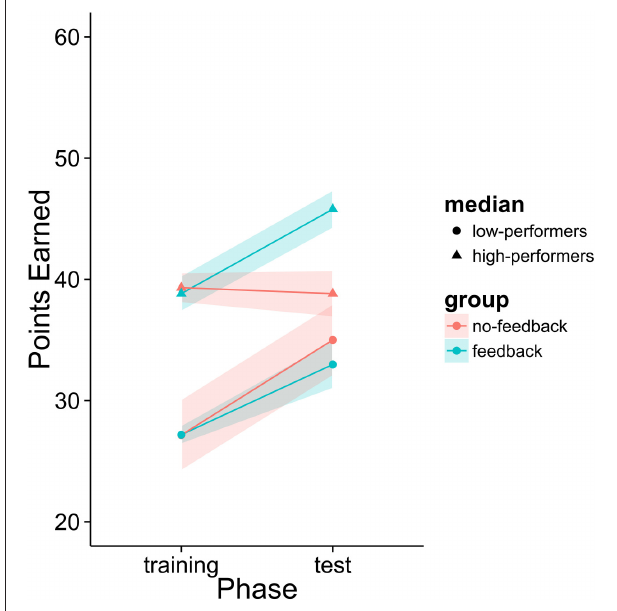
FIGURE 13 | Percentage of points earned after dividing participants into high and low performance groups.